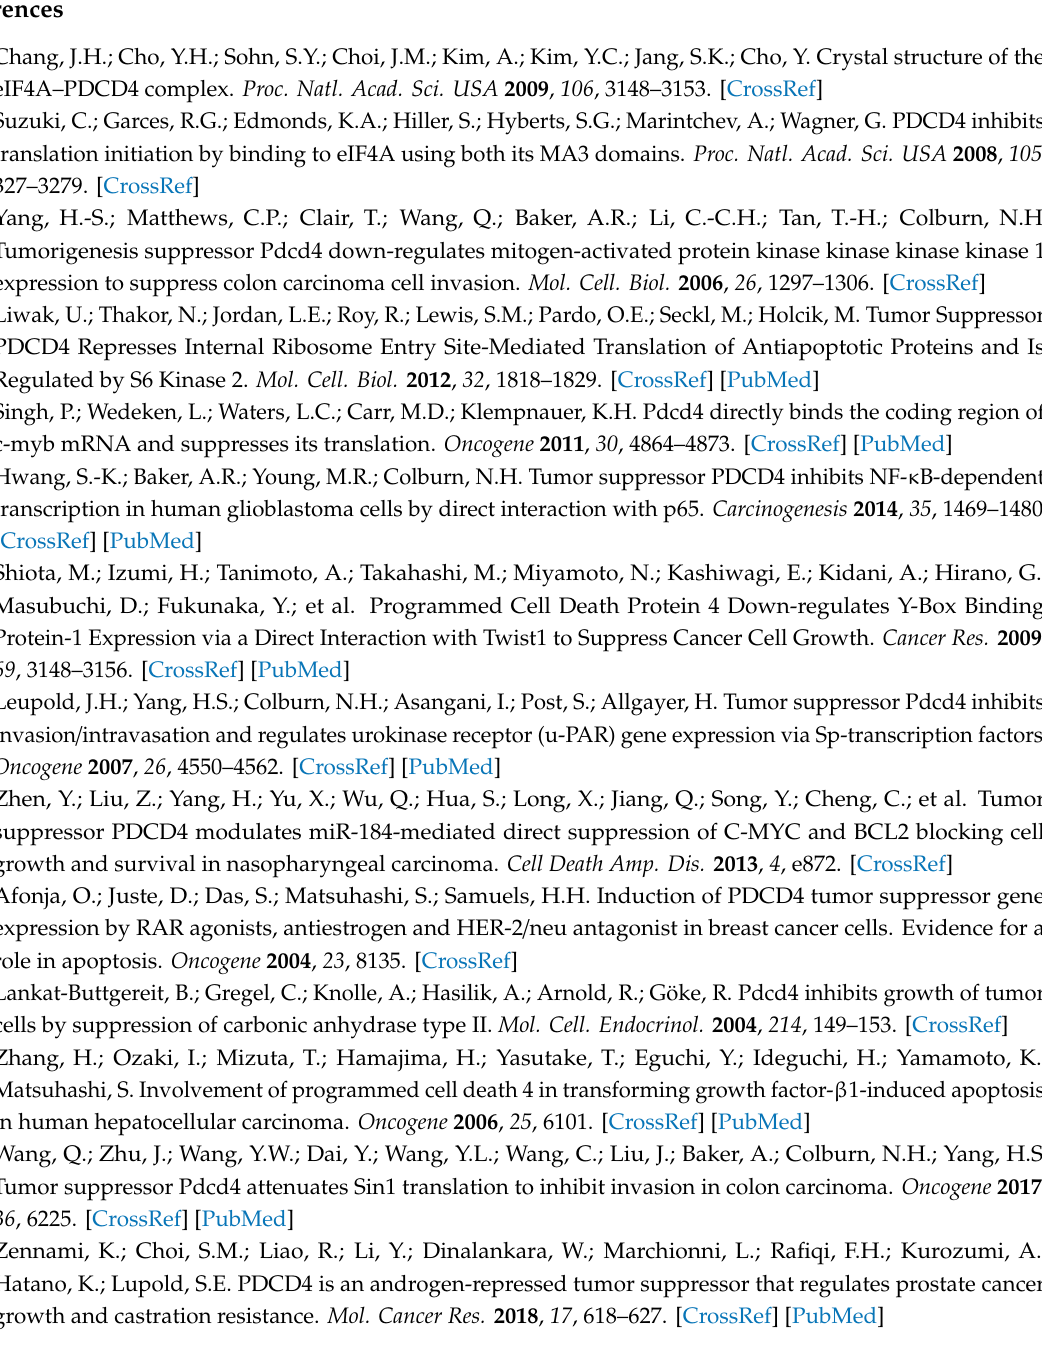
Figure S3: Colocalization of PDCD4, p62 and LC3 was increased in the presence of both bafilomycin A1 and / or MG132 in both wild-type (A) and ATG5-16 mutant (B) Huh7